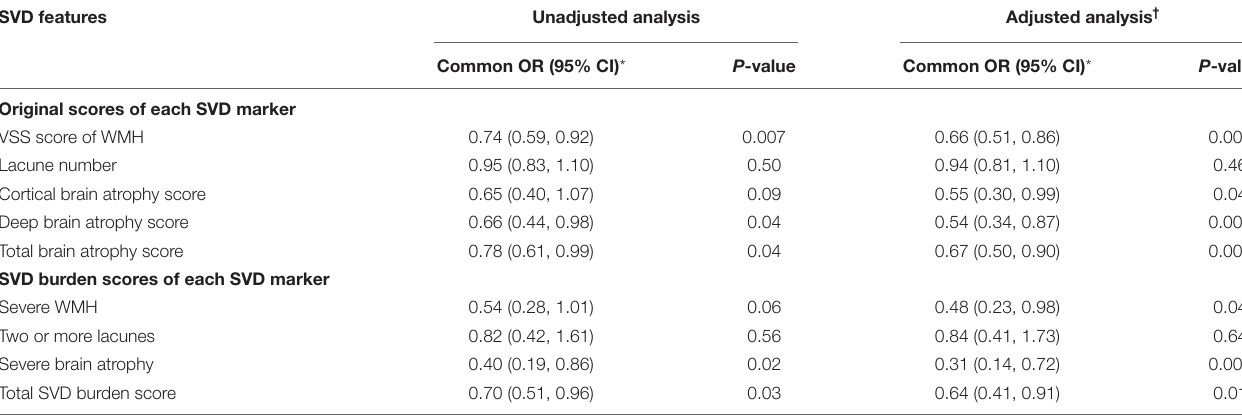
TABLE 3 | Ordinal logistic regression analysis with mRS score at 90 days as the dependent variable and SVD features as independent variables. SVD